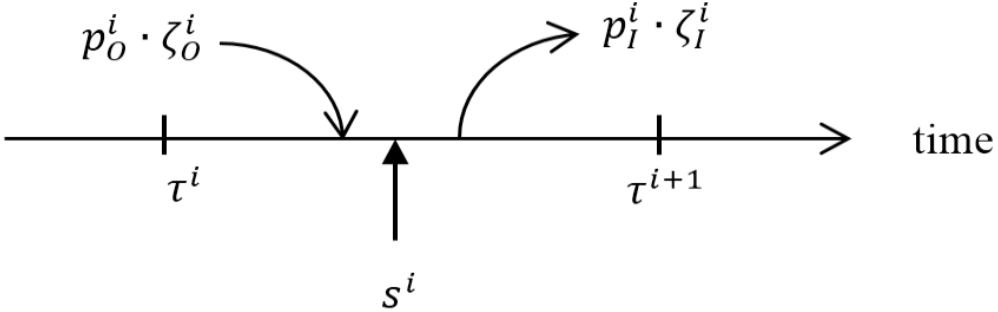
Figure 2. Flow of Figure 2. Flow of money.